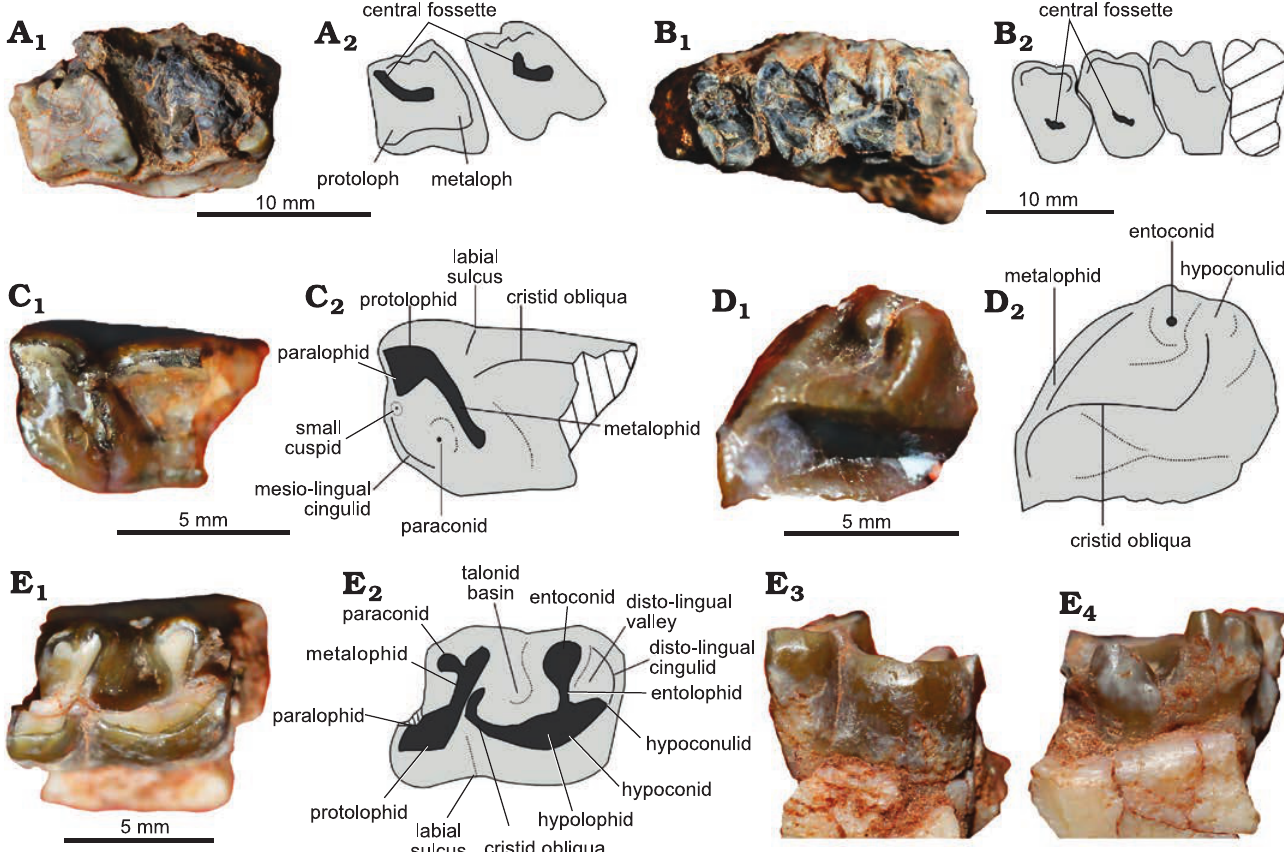
Fig. 3. New fossil specimens of Typotheria and Toxodontia from the Quebrada de Los Colorados Formation exposed at Quebrada Grande locality, Los Cardones National Park (Salta Province), Casamayoran SALMA. A , B . Col bertia sp. A . IBIGEO-P 58a, left maxillary fragment with M2–M3 in occlusal view. B . IBIGEO-P 58b, left maxillary fragment with P4–M3 in occlusal view. C – E . Pampahippus secundus Deraco and García-López, 2016. C . IBIGEO-P 62, right trigonid and incomplete talonid of a lower right molar in occlusal view. D . IBIGEO-P 63, fragmented left p3 or p4 in occlusal view. E . IBIGEO-P 64, left m1? in occlusal (E 1 ), labial (E 2 ), and lingual (E 3 ) views. Photographs (A 1 –E 1 , E 3 , E 4 ), explanatory drawings (A 2 –E 2 ). Dashed area indicates broken or missing dental